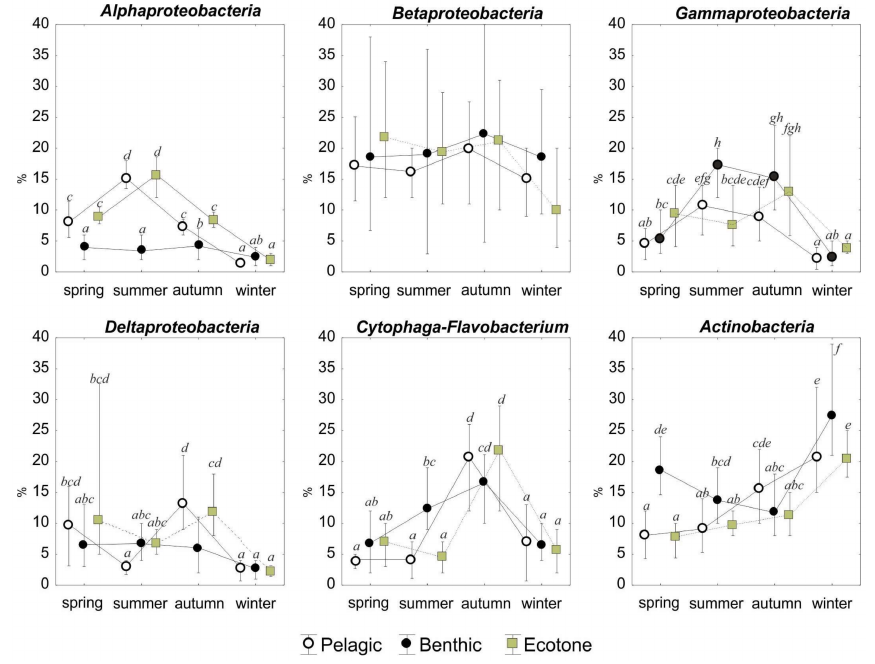
Figure 5. Seasonal changes in the Eubacteria for the studied Suchar lakes. Values are expressed as the percentage of hybridized cell counts of TBN of DAPI-stained cells. Error bars represent standard errors. Means that do not share superscripts differ by p < 0.05 according to the Tukey’s test (post hoc, two-way ANOVA). The combination of superscript letters shows groups of means that do not differ significantly from each other.